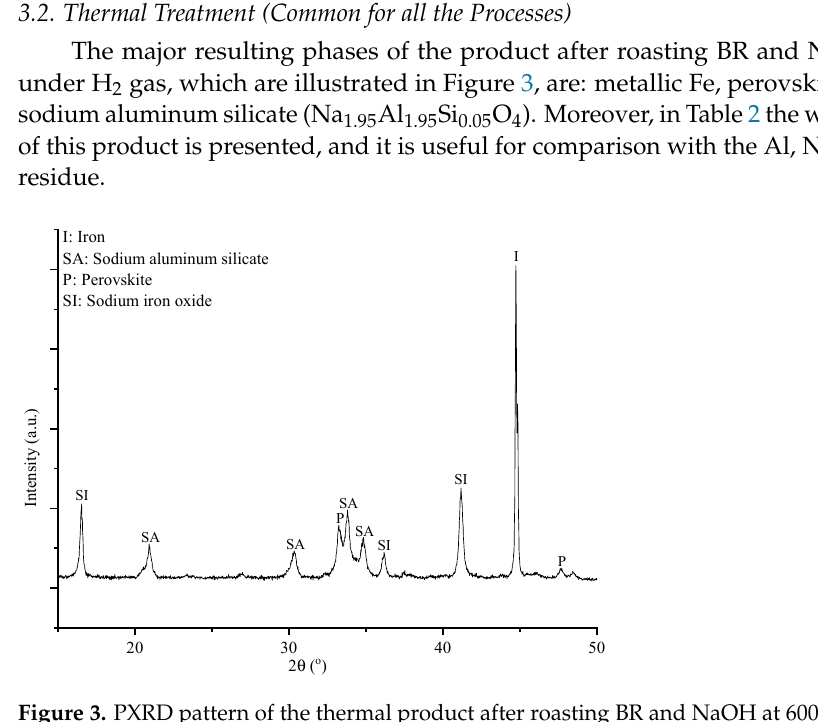
Figure 3. PXRD pattern of the thermal product after roasting BR and NaOH at 600 °C, under H 2 gas.